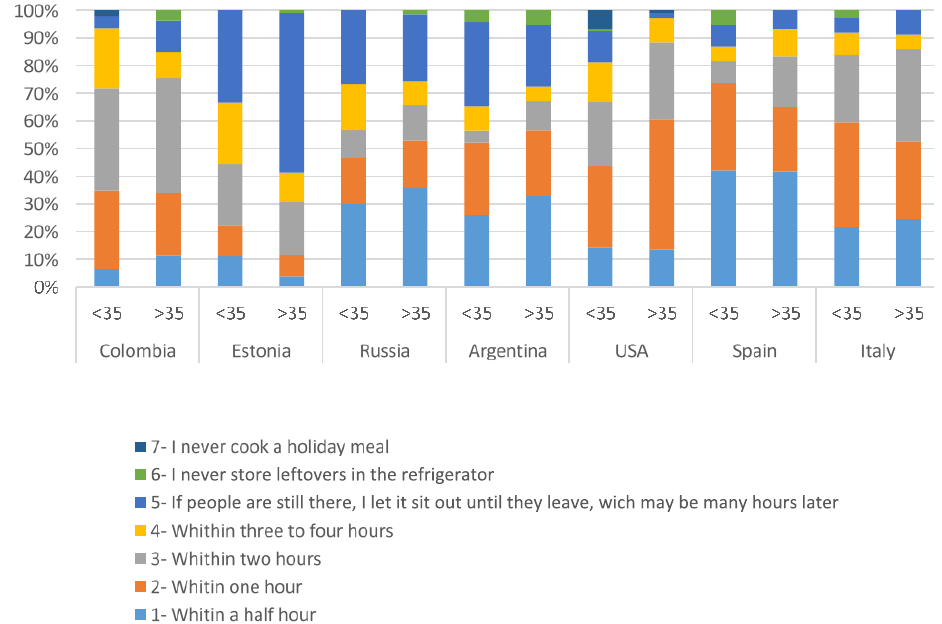
Figure 3. You have prepared food for a holiday meal and there is food left over. How long do you generally let it sit out at room temperature before putting it in the refrigerator? (Select one.) Results presented for respondents aged <35 and ≥35 in each country, by percentage.